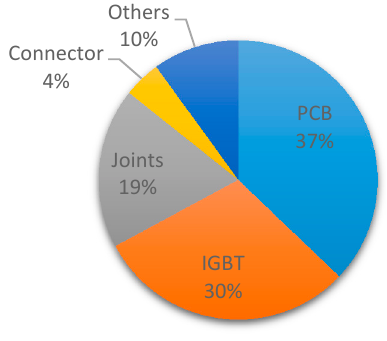
Figure 5. Failure rate distribution of power electronic converter for wind turbine system [10].